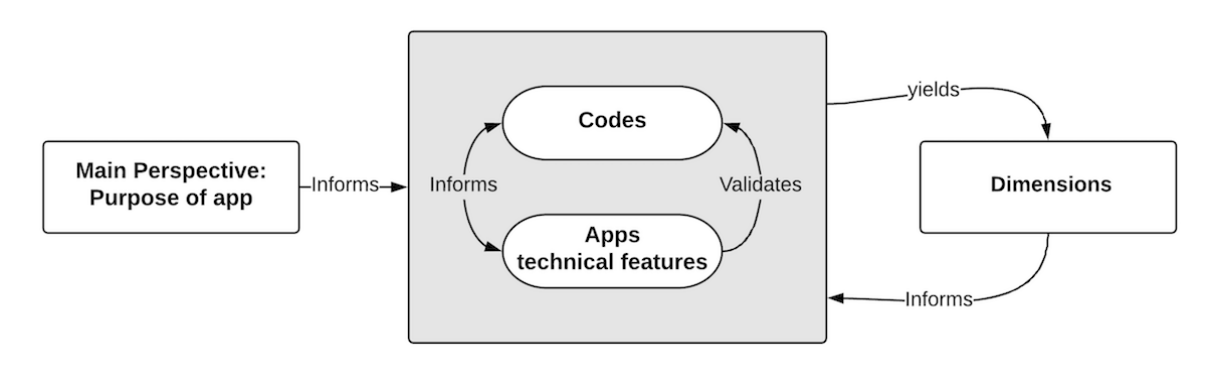
Figure 1. Our approach to defining purposes of apps related to COVID-19.